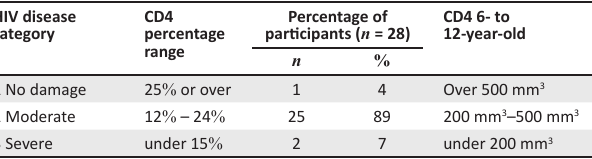
TABLE 1: Cluster of differentiation 4 (CD4) percentage and CD4 count for children according to Word Health Organization 2015 guidelines. HIV disease